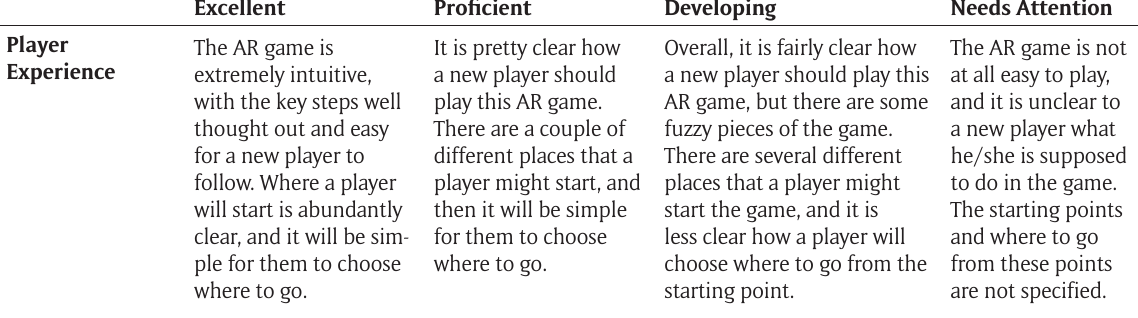
Table 1: Rubric for Assessing Augmented Reality (AR) Challenge